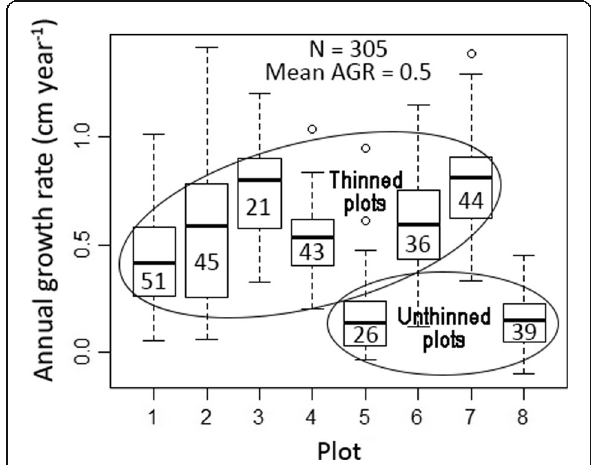
Fig. 2 Diameter annual growth rates across the plots in Woodside. The boxes represent 25th and 75th percentiles with the median represented by horizontal bars . The number in each box corresponds to the number of observations. Lines are either extreme values or 1.5 times the interquartile range, and open dots are outliers. Mean overall AGR = 0.5 cm year − 1 . Mean AGR in thinned plots =